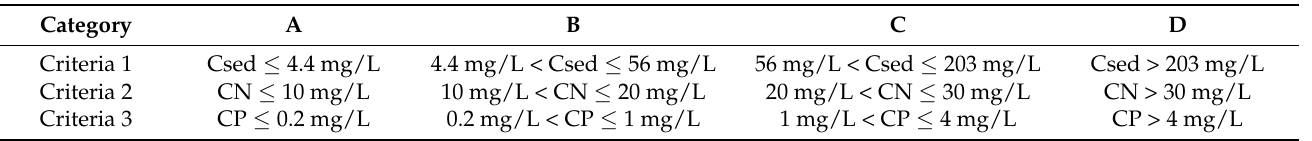
Table 2. Criteria for classification of water quality in the source (Csed: Concentration of total suspended solids, CN: Concentration of nitrogen, CP: Concentration of phosphorus).